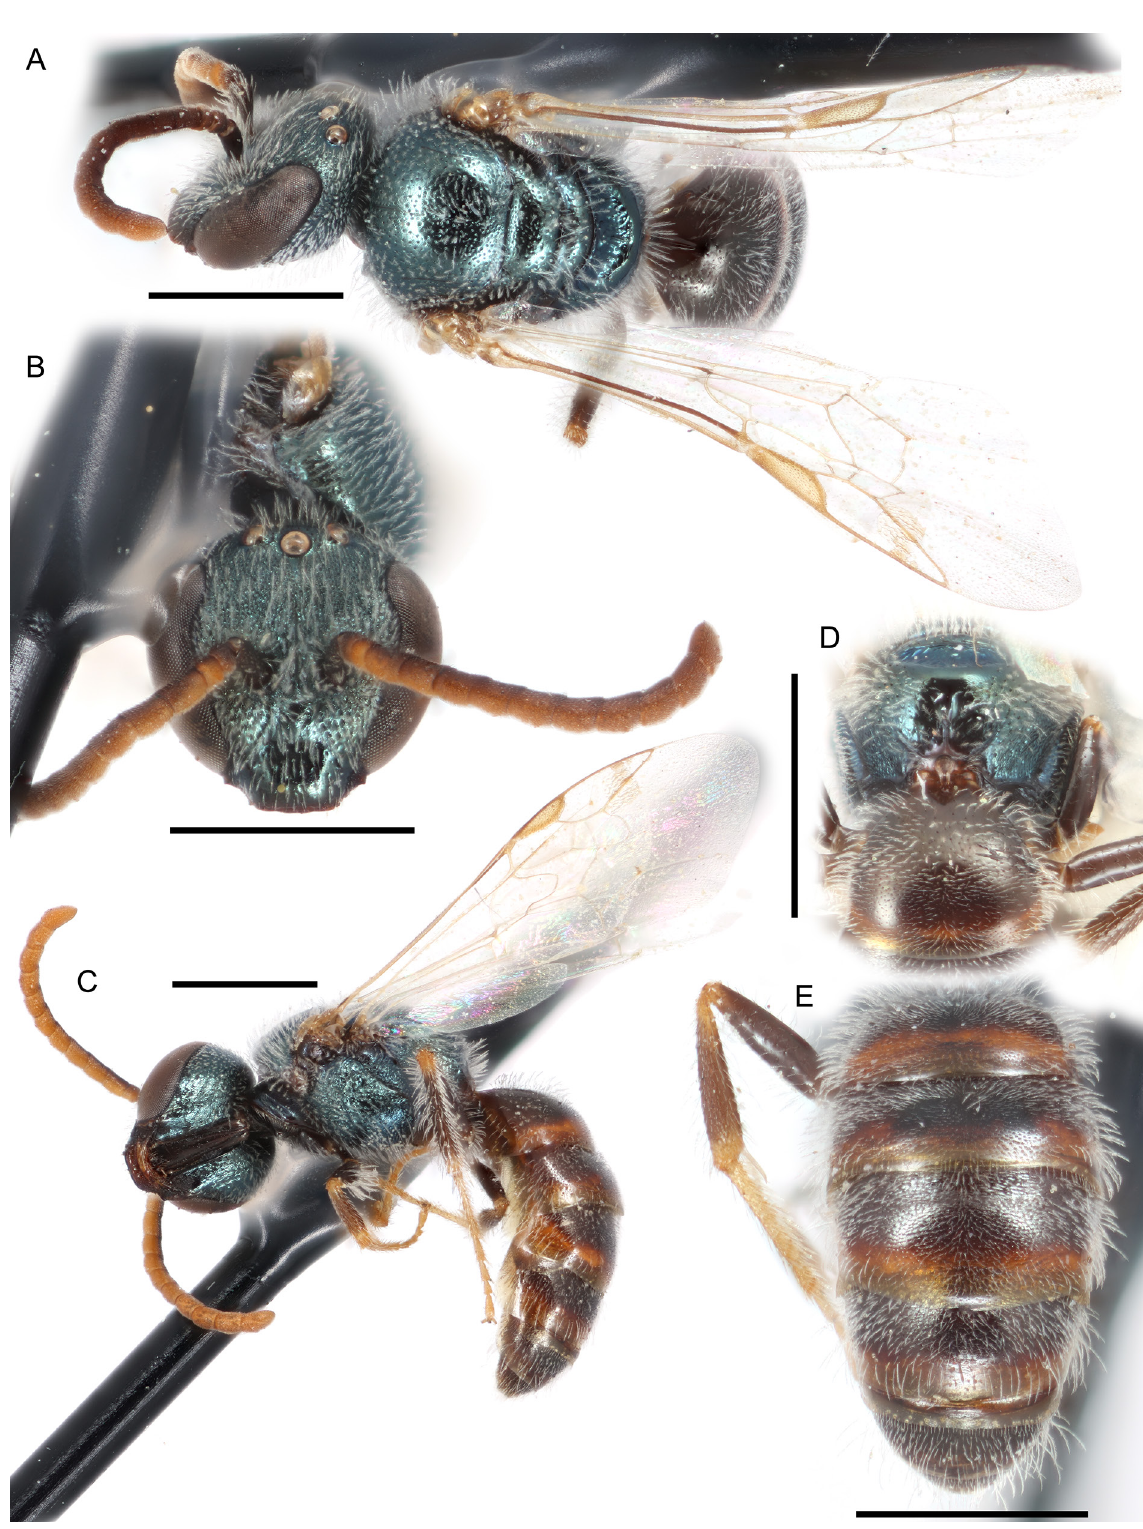
Fig. 62. Lasioglossum ( D. ) miltolepoides sp. nov., ♂. A . Dorsal habitus. B . Face. C . Lateral habitus. D . Propodeum. E . Metasoma. Scale bars: 1